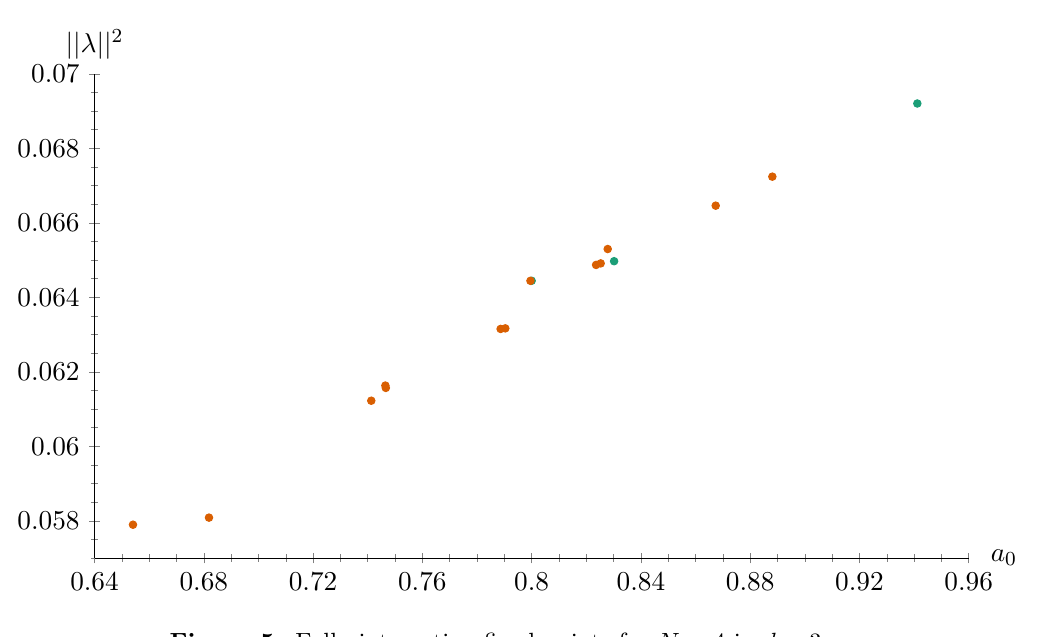
Figure 5. Fully-interacting fixed points for N = 4 in d = 3 − ε